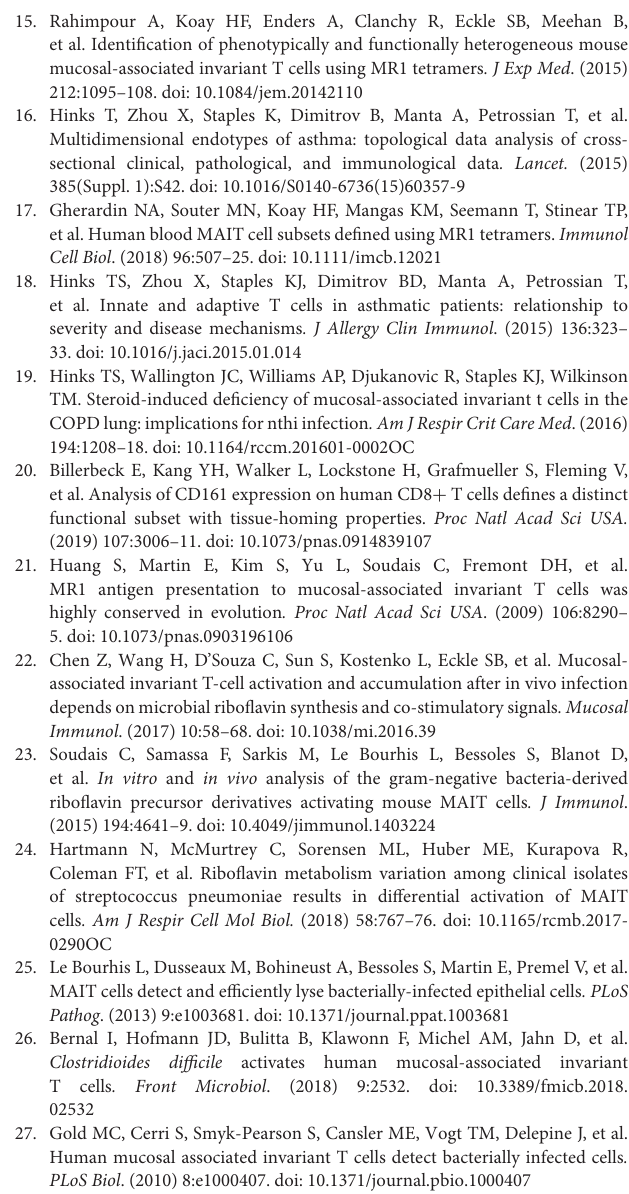
Supplementary Table 1 | Effects on MAIT cell activation and functions of various bacterial